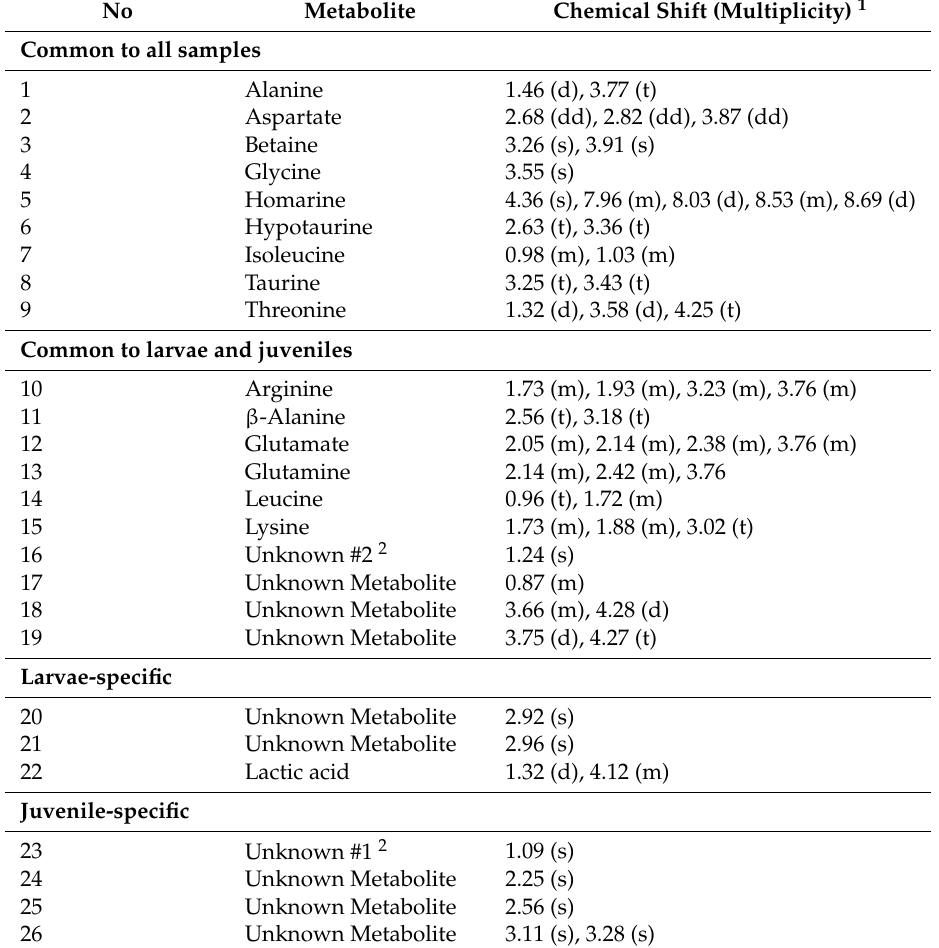
Table 1. Table of common metabolites identified in Mytilus